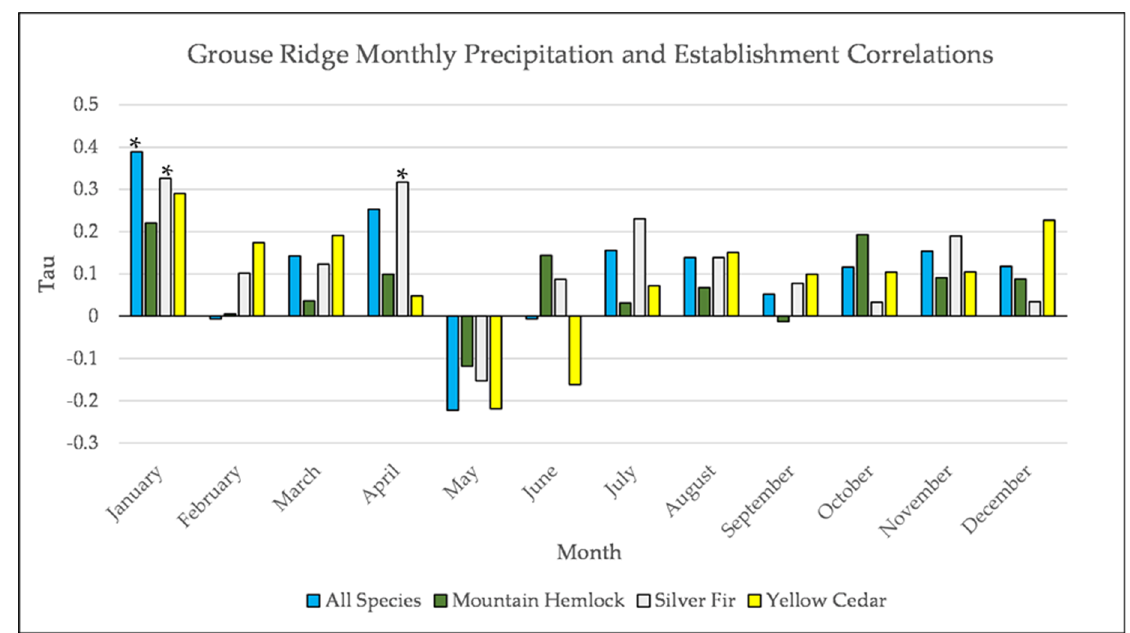
Figure A12. Partial Kendall’s correlation between mean monthly precipitation and establishment at the Scott Paul site. * = p -value < 0.05.